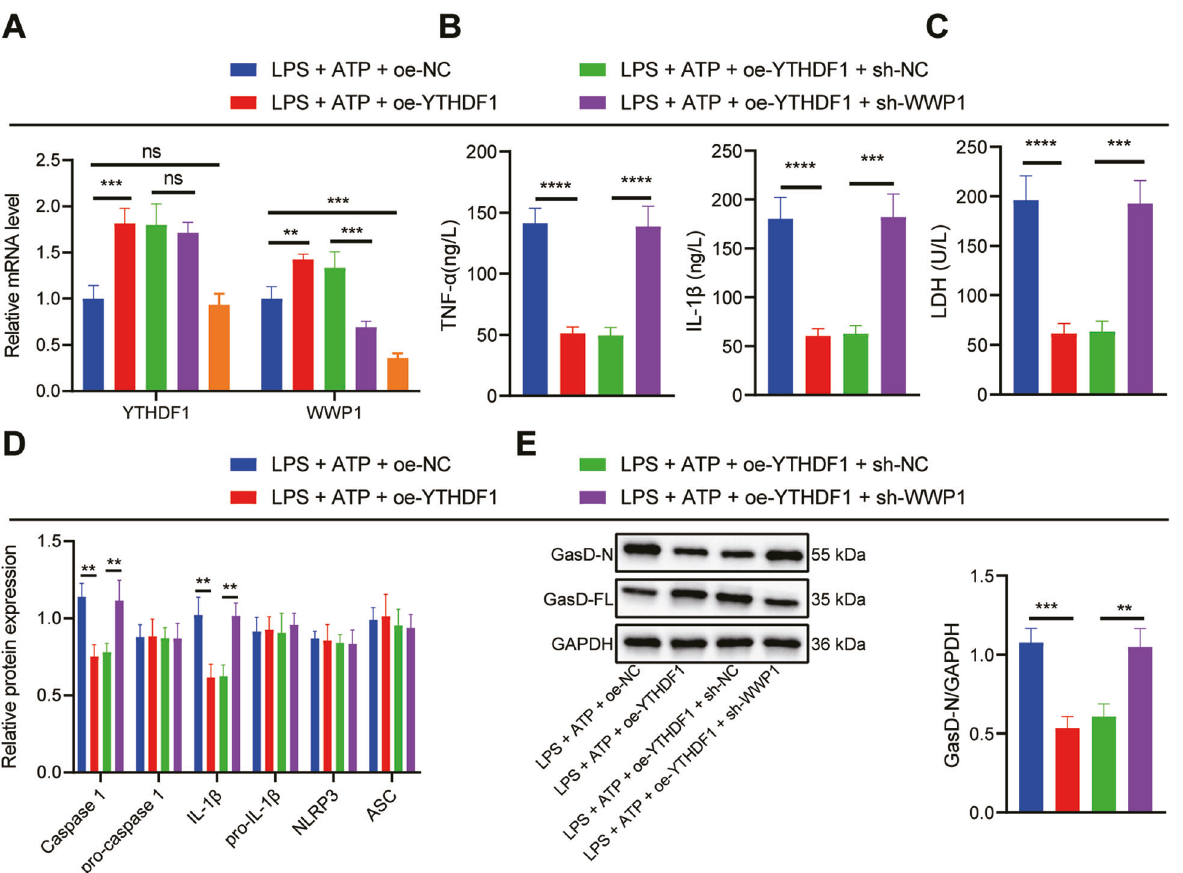
Fig. 4 Upregulation of WWP1 by YTHDF1 inhibits activation of NLRP3 in fl ammasomes and caspase-1-mediated cleavage of GSDMD. A The expression of YTHDF1 and WWP1 in cells with different treatment assessed by RT-qPCR. B The expression of TNF- α and IL-1 β determined by ELISA. C LDH level in cells with different treatment. D The activation of NLRP3 in fl ammasomes measured by Western blot assay. E Protein levels of GasD-N and GasD-FL detected by Western blot assay. * p < 0.05; ** p < 0.01; *** p < 0.001; **** p < 0.0001. ‘ ns ’ indicates no signi fi cant difference. Cell experiments were repeated 3